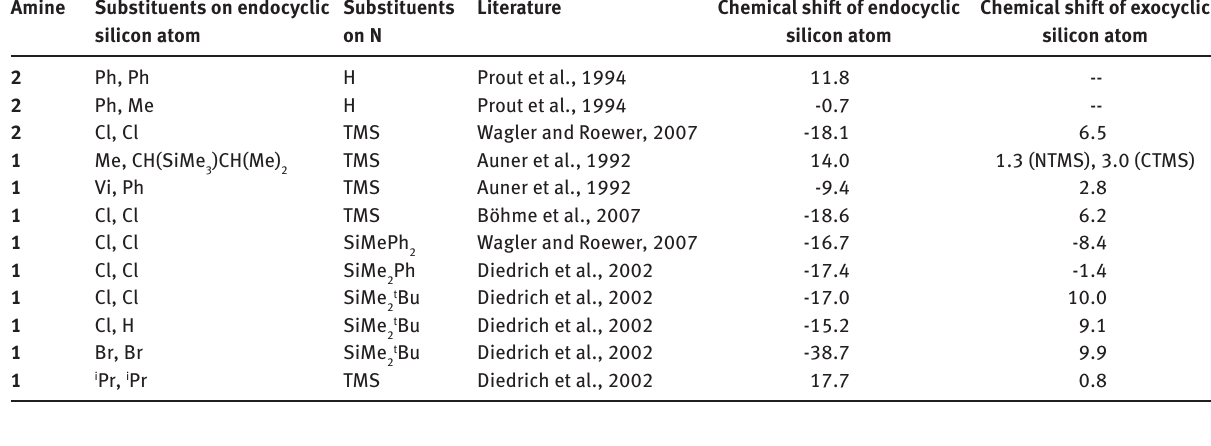
Table 2: 29 Si NMR data of compounds taken from literature Amine